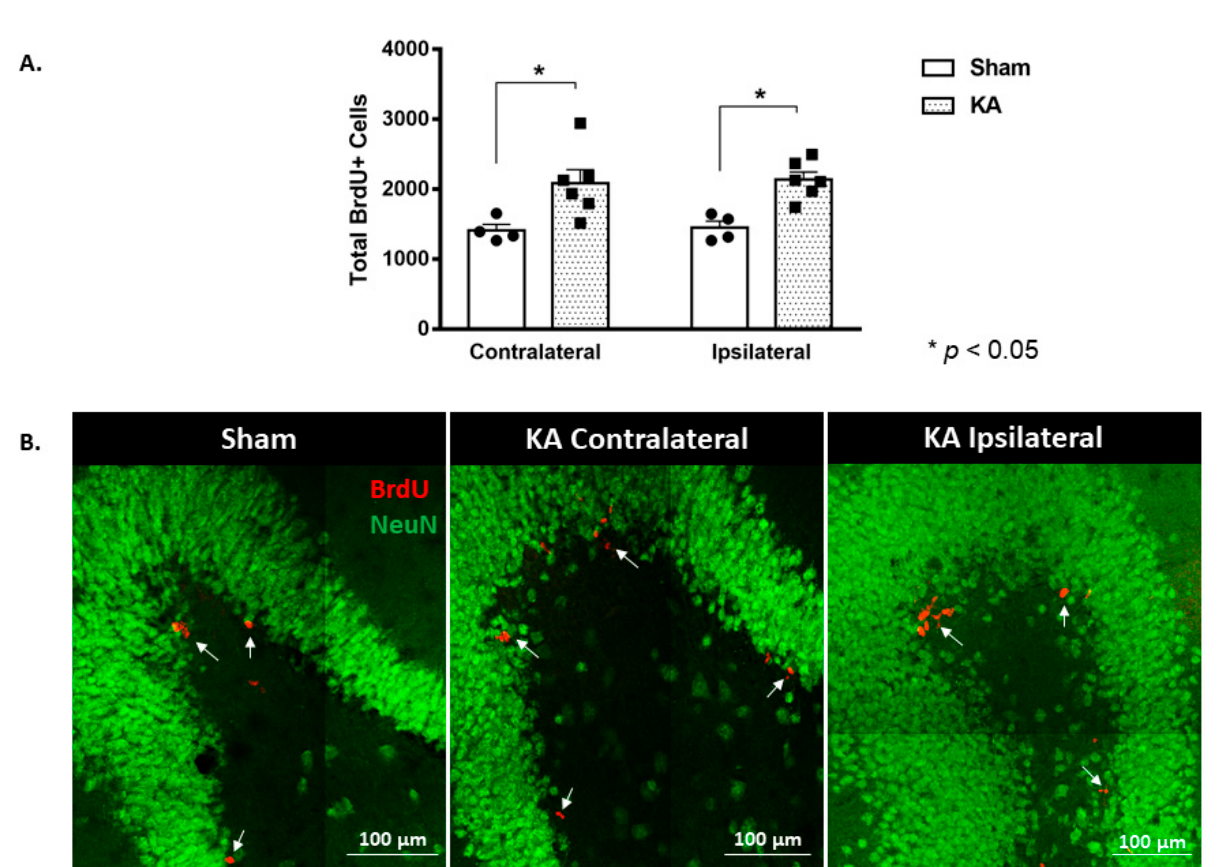
Figure 2. Bilateral increase in the proliferation of progenitor cells in the dentate gyrus at week 1 following unilateral continuous micro-perfusion of kainic acid into the AN. ( A ) Stereological quantification of BrdU-labeled cells in the DG of the KA micro-perfused ( n = 6) and sham ( n = 4) groups. Each bar represents the average ± SEM of the BrdU quantification. Two-way ANOVA followed by Tukey’s multiple comparison test was used to determine the significance between the KA micro-perfused and sham groups at both the ipsilateral and contralateral sides. ( B ) Representative confocal images showing immunofluorescence labeling of NeuN and BrdU (arrows) in the DG of the different groups. Images were taken as Z stacks using a 40×-oil objective.